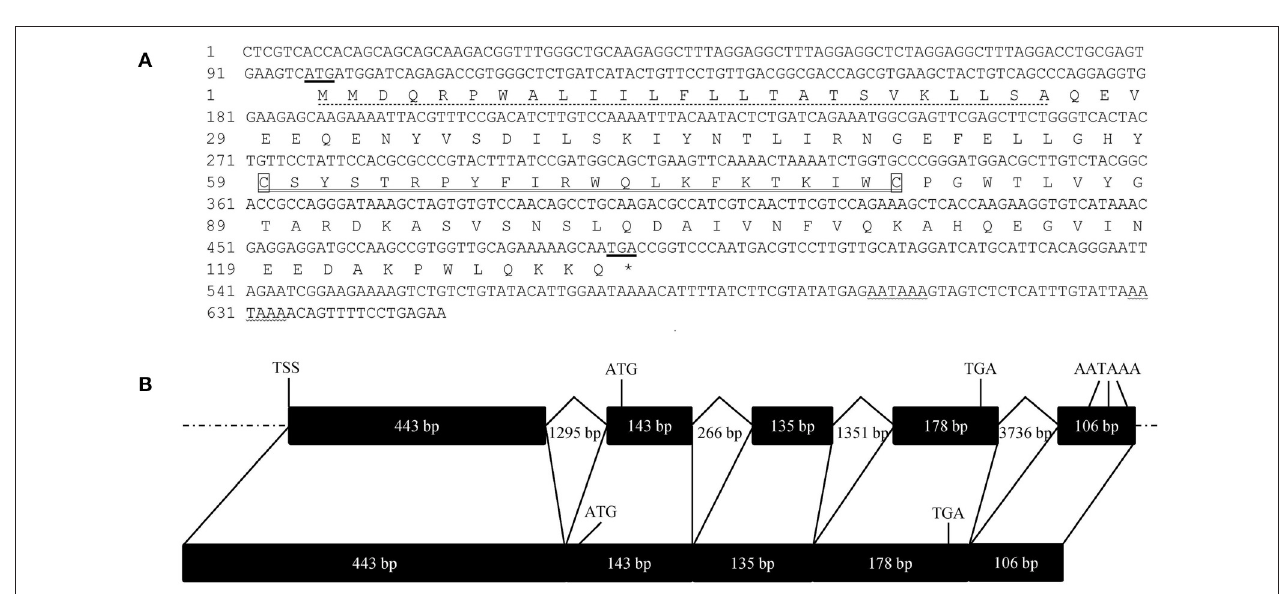
FIGURE 1 | Nucleotide sequence, deduced amino acid sequence and gene structure of FcALF8 . (A) showed the nucleotide sequence and deduced amino acid sequence of FcALF8 . The start codon and stop codon were underlined. The predicted polyadenylation sites were wave-underlined. The predicted signal peptide was dotted-underlined. The putative LPS-binding domain was double-underlined. (B) showed the gene structure of FcALF8 . Exons and introns with indicated length were shown as black boxes and broken lines, respectively. Flanking DNA sequences were shown as dotted lines. TSS showed the putative t ranscription s tart s ite. The location of start codon (ATG), stop codon (TGA), and polyadenylation signals (AATAAA) were marked in the DNA and mRNA sequences of FcALF8 .